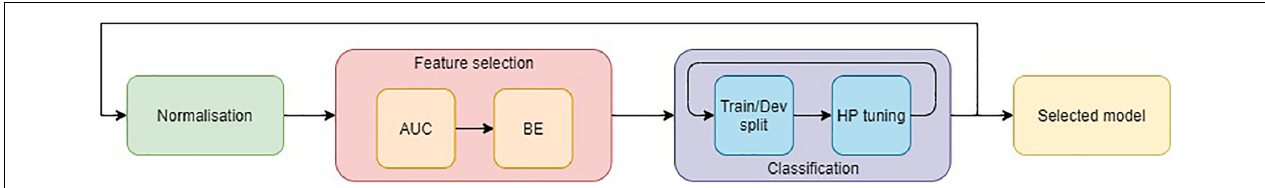
FIGURE 7 | Model selection pipeline for machine learning.